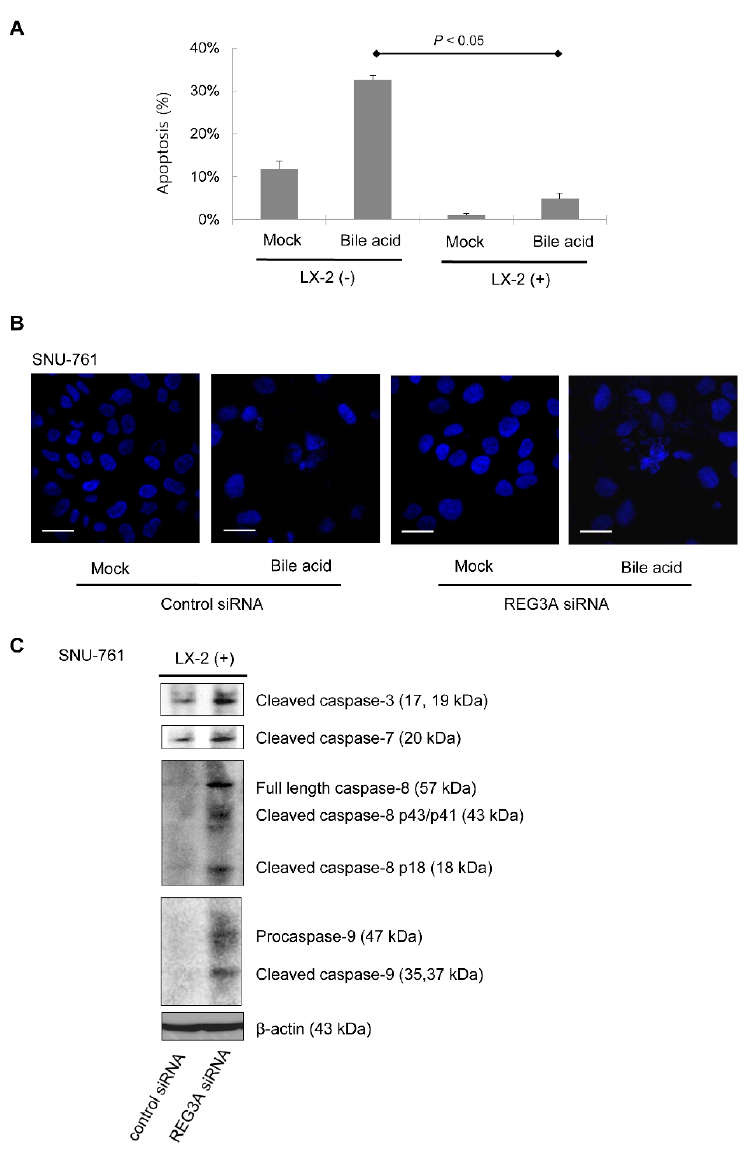
Figure 3. The effects of REG3A on bile acid-induced apoptosis of HCC cells cocultured with HSCs. ( A ) SNU-761 cells were monocultured or cocultured with LX-2. After 24 h, cells were treated with deoxycholate (300 µ M) for 2 h. Apoptosis was assessed using 40,6-diamidino-2-phenylindole dihydrochloride (DAPI) staining. Data are expressed as mean ± SD from three different experiments ( p < 0.05, vs. mono-culturing without LX-2). The experiment was repeated three times. ( B ) On fluorescence microscopy, SNU-761 cells cocultured with LX-2 cells were significantly more resistant to bile acid (deoxycholic acid 300 μ M)-induced SNU-761 cell apoptosis compared with monocultured cells. Scale bars, 50 μ m. ( C ) Immunoblot analyses of caspase 3, 7, 8, and 9 were performed in SNU-761 cells cocultured with LX-2 cells. The experiment was repeated three times. 2.4. The Antitumor Mechanism of REG3A in HCC Cells Cocultured with HSCs: p42/44 Pathway